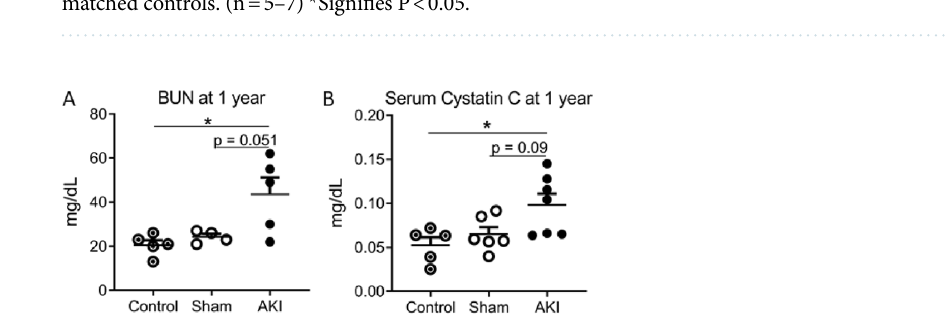
Fig. 3E. Overall, these data mirror the 1 year α-SMA and fibrosis marker findings in the male cohorts 21 , however, the female AKI cohorts demonstrated a higher absolute quantification of Collagen 3, and Picrosirius Red stain- ing, but not hydroxyproline content, compared to males (Supplementary Table 1). Effect of sex on cardiac outcomes after AKI. Serial echocardiograms were performed to measure mitral annular tissue velocities during early (E ′ ) and late (A ′ ) phases of diastole. A low E ′ /A ′ ratio represents impairment in left ventricular wall relaxation during diastole. Female mice had preservation of cardiac function throughout the 1-year study (Fig. 4A). Mean arterial blood pressure measurements demonstrated hypertension in females after AKI at 6 and 9 months (Fig. 4B) but not at 1 year. There was no difference in end diastolic left ventricular (LV) anterior (Fig. 4C) or posterior (Fig. 4D) wall thickness, ejection fraction (Fig. 4E) or fractional shortening (Fig. 4F) between sham and AKI cohorts at 6-, 9- or 12-months post-procedure. There was no dif- ference in LV mass, controlled for tibia length (Fig. 4G) or LV collagen content (Fig. 4H) at 1 year amongst the AKI or sham cohorts. Overall, females had preserved diastolic function and the hypertension resolved by 1-year, compared to the male AKI counterparts that had diastolic dysfunction which preceded persistent hypertension 21 . Effect of sex on the cardiac and plasma metabolome.